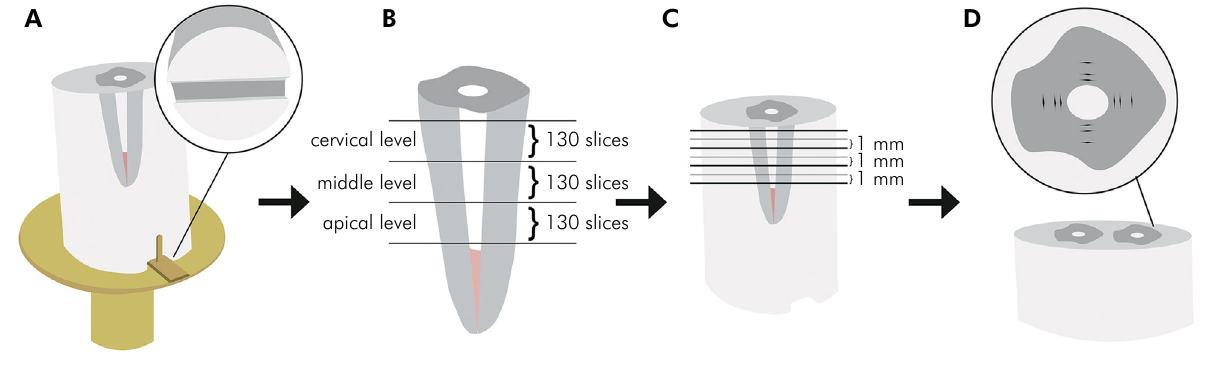
Figure 1. Schematic figure of the methodologies for micro-CT and Knoop test: (A) Sample placed in a standardized position during the micro-CT scans, using a custom device; (B) the region to be analyzed was divided to represent the cervical, middle and apical levels in the PSP, with 130 slices at each level; (C) two 1-mm-thick root slices were obtained from each PSP level; (D) four indentations were made around the canal lumen at three dentin depths.